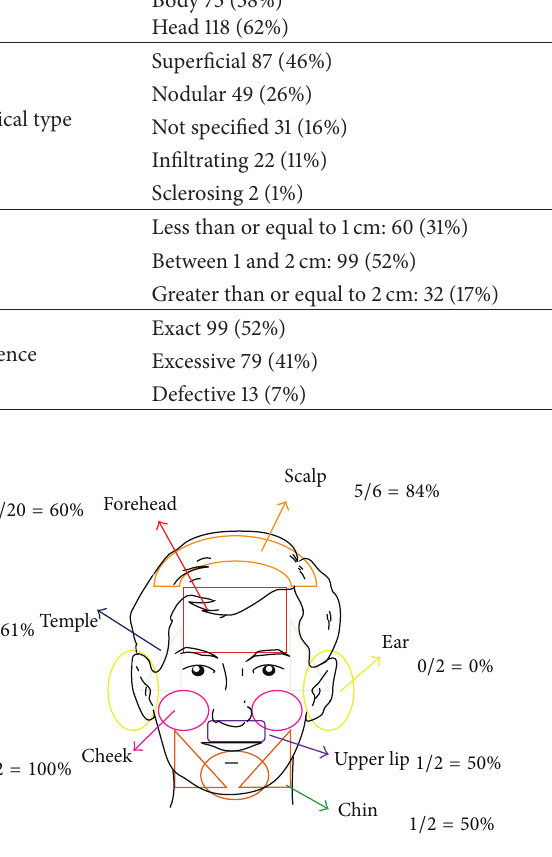
Figure 1: Number of BCC, location, and response in the head.